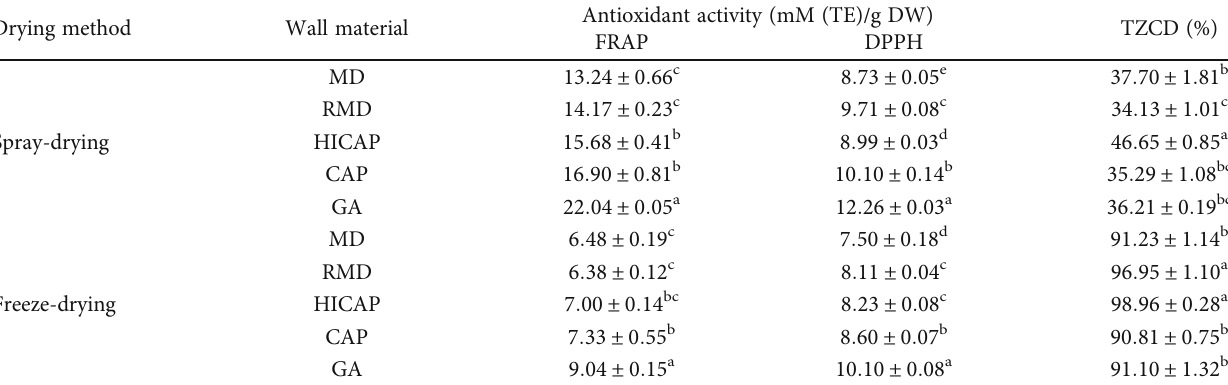
Table 4: Antioxidant activity and TZCD of spray- and freeze-dried Zn-amaranth powders encapsulated with 10% (w/w) of di ff erent wall materials.